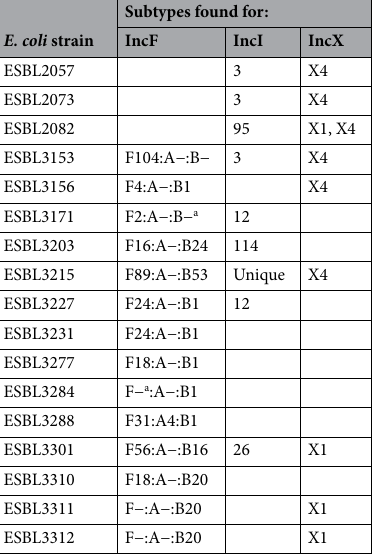
Table 2. Subtypes found per strain for the three most commonly found incompatibility groups: IncF, IncI and IncX. a Subtype contains a novel allele and can therefore not be fully